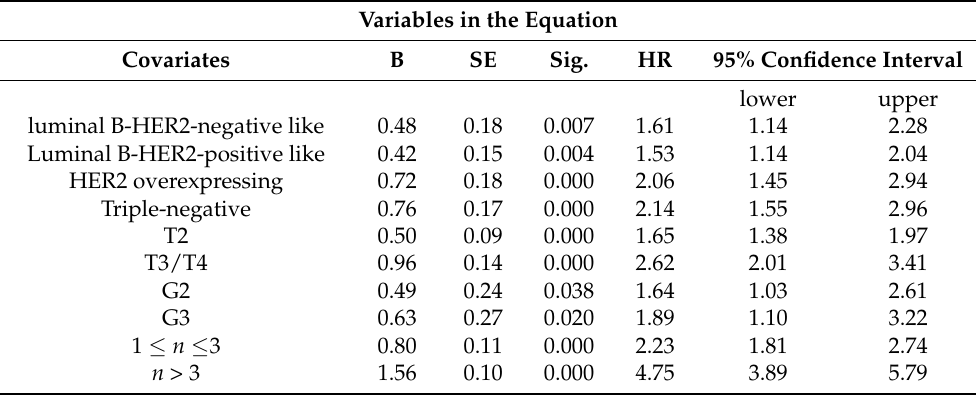
Table 2. Cox regression model for metastasis-free survival including intrinsic subtypes, tumour size, grading and nodal status. B beta coefficient; SE standard error; Sig. significance; HR hazard ratio; CI confidence interval with lower and upper limit. Variables in the Equation Covariates B Sig.